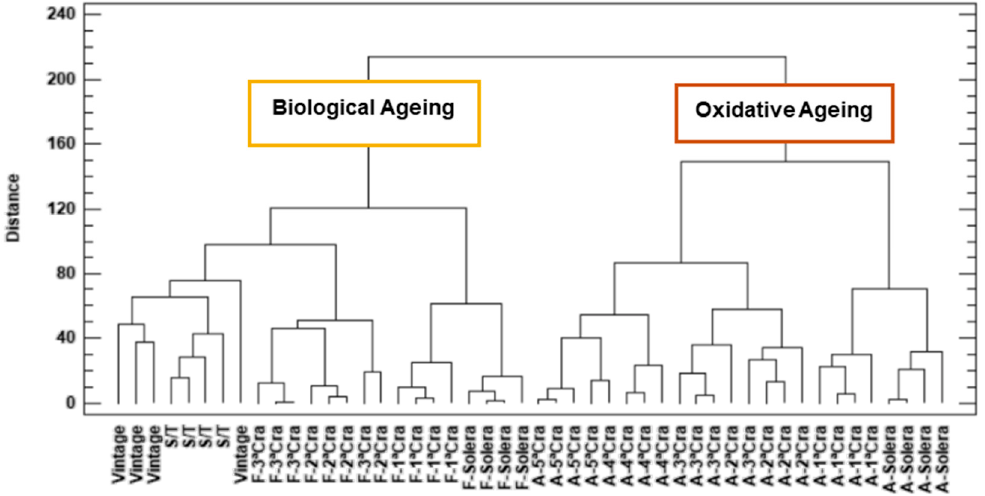
Figure 2. Cluster analysis (Ward’s method, Euclidean distance) of the Sherry wines studied.